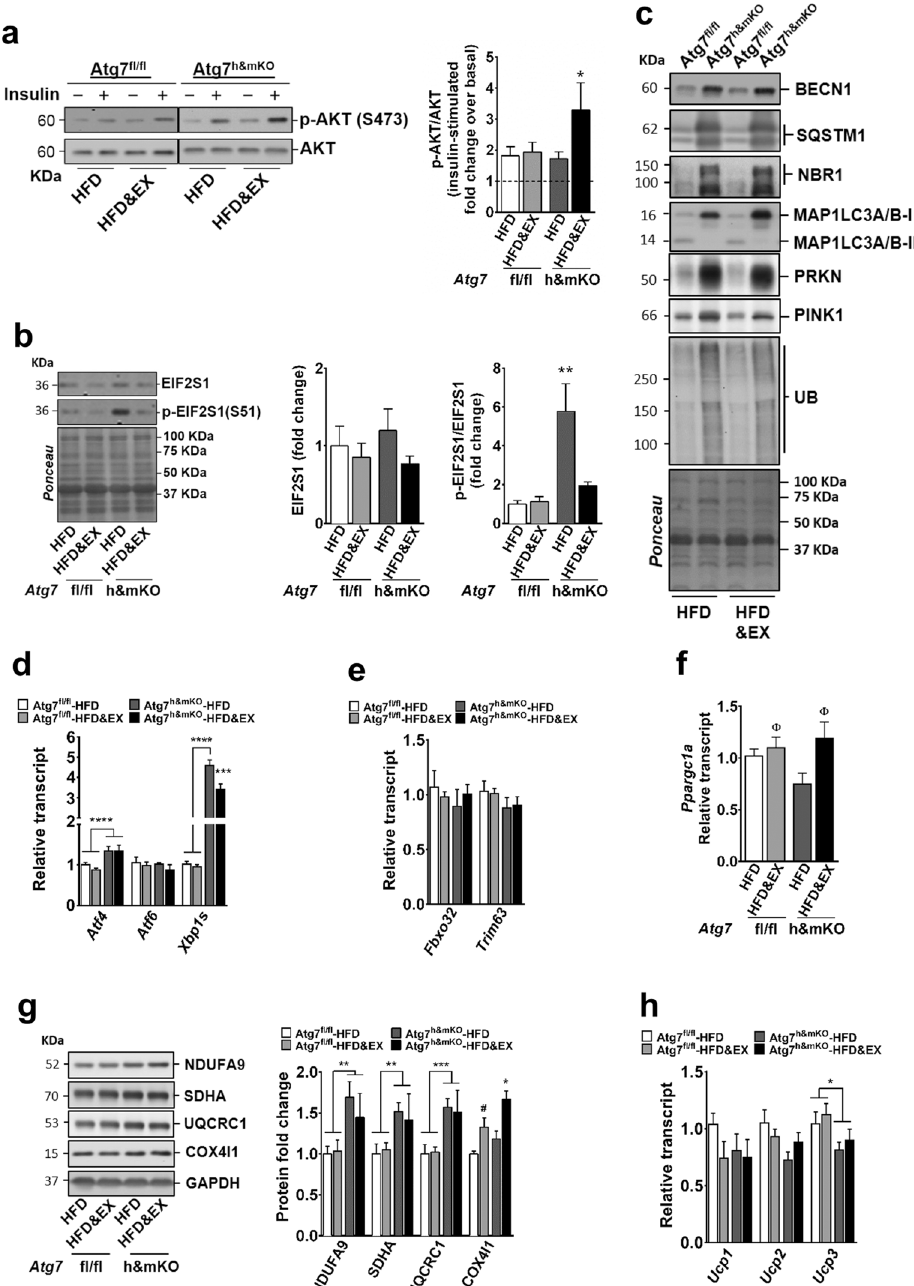
Figure 4. Insulin signalling, ER stress and mitochondrial biogenesis are favourably modulated by exercise training in skeletal muscle of Atg7 h&mKO mice. ( a ) Immunoblot representative images of the mean value (dividing lines indicate blots from different gels) and related quantification of phosphorylated AKT(S473) normalized to total AKT under basal and insulin-stimulated conditions (dashed line represents basal AKT phosphorylation) (n = 6–11). ( b ) Immunoblot representative images of the mean value and related quantification of total EIF2S1 normalized to ponceau staining, and phosphorylated EIF2S1(S51) normalized to total EIF2S1 (n = 5–6). ( c ) Immunoblot representative images of the mean value for select autophagy, mitophagy and ubiquitinated proteins (n = 4). ( d ) mRNA analysis of ER stress effector genes (n = 5–9). ( e ) mRNA analysis of E3 ubiquitin ligase genes (n = 5–9). ( f ) mRNA analysis of Ppargc1a (n = 5–9). ( g ) Immunoblot representative images of the mean value and quantification of mitochondrial proteins of complexes 1–4 of the Electron Transport Chain normalized to glyceraldehyde 3-phosphate dehydrogenase (GAPDH; n = 5–10). ( h ) mRNA analysis of Ucp1 , Ucp2 and Ucp3 (n = 5–9). Full-length blots are presented in Supplementary Fig. S5. * P < 0.05, ** P < 0.01, *** P < 0.001, **** P < 0.0001 in comparison to all other groups unless otherwise represented; Φ P < 0.05 in comparison to respective HFD only, sedentary group; and # P < 0.05 in comparison to Atf7 fl/fl